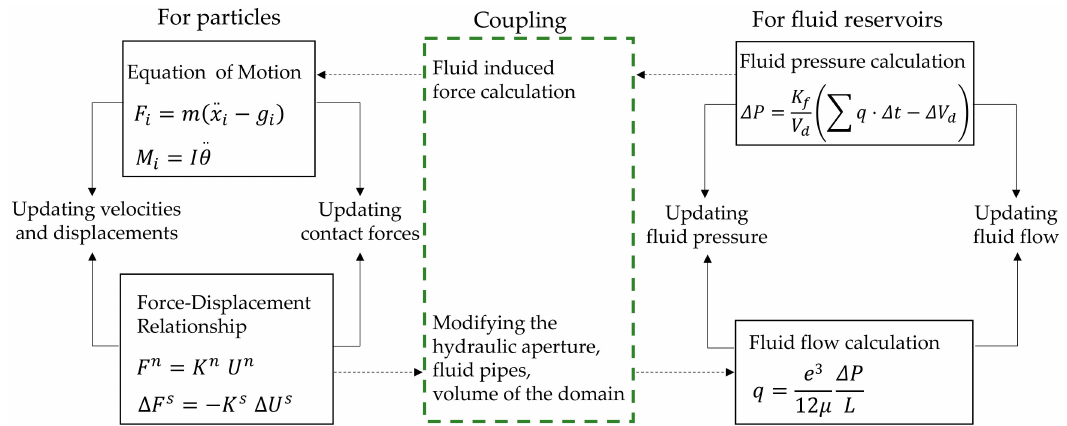
Figure 2. The basic mechanism of fluid-mechanical coupling [28].